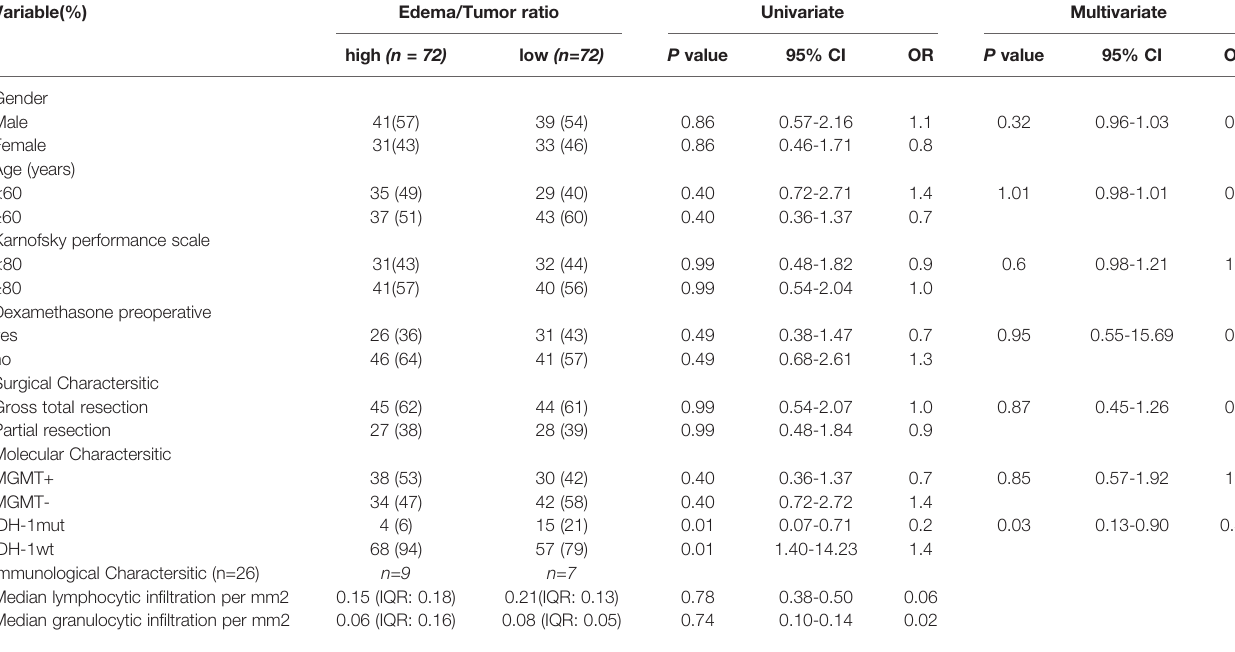
TABLE 2 | Uni- and multivariate analysis of juxtaposed characteristics according to edema to tumor ratio. Variable(%) Edema/Tumor